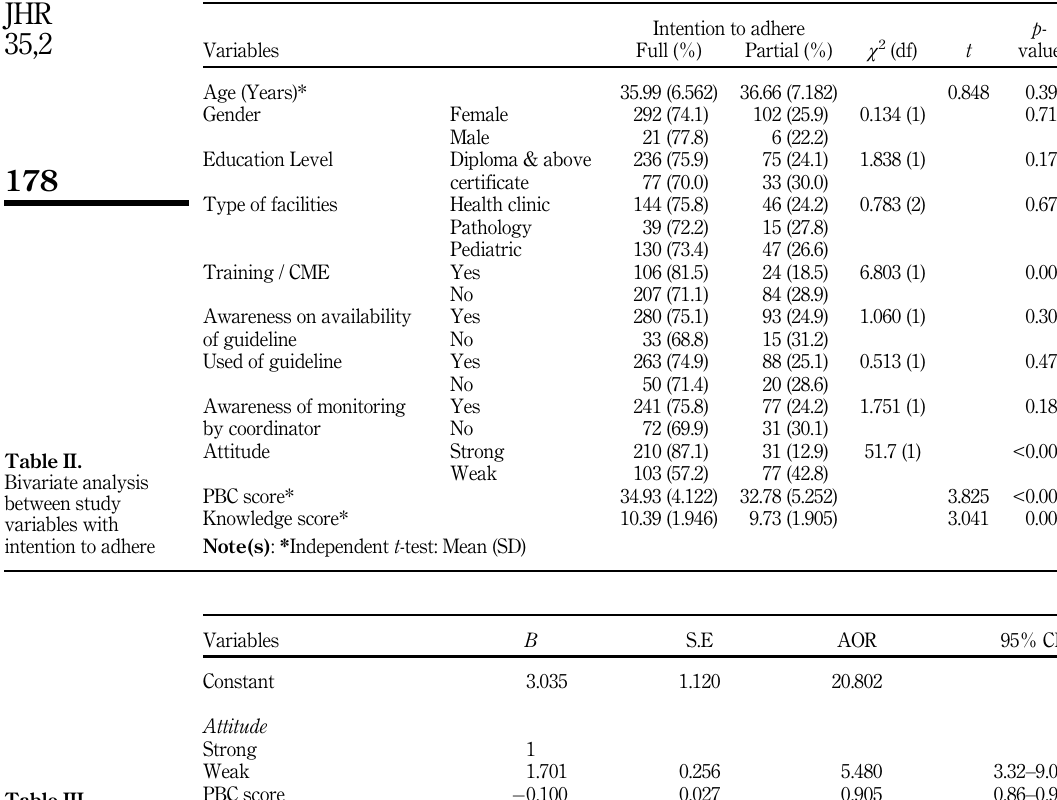
Table III. Multiple logistic regression for determinant of intention to